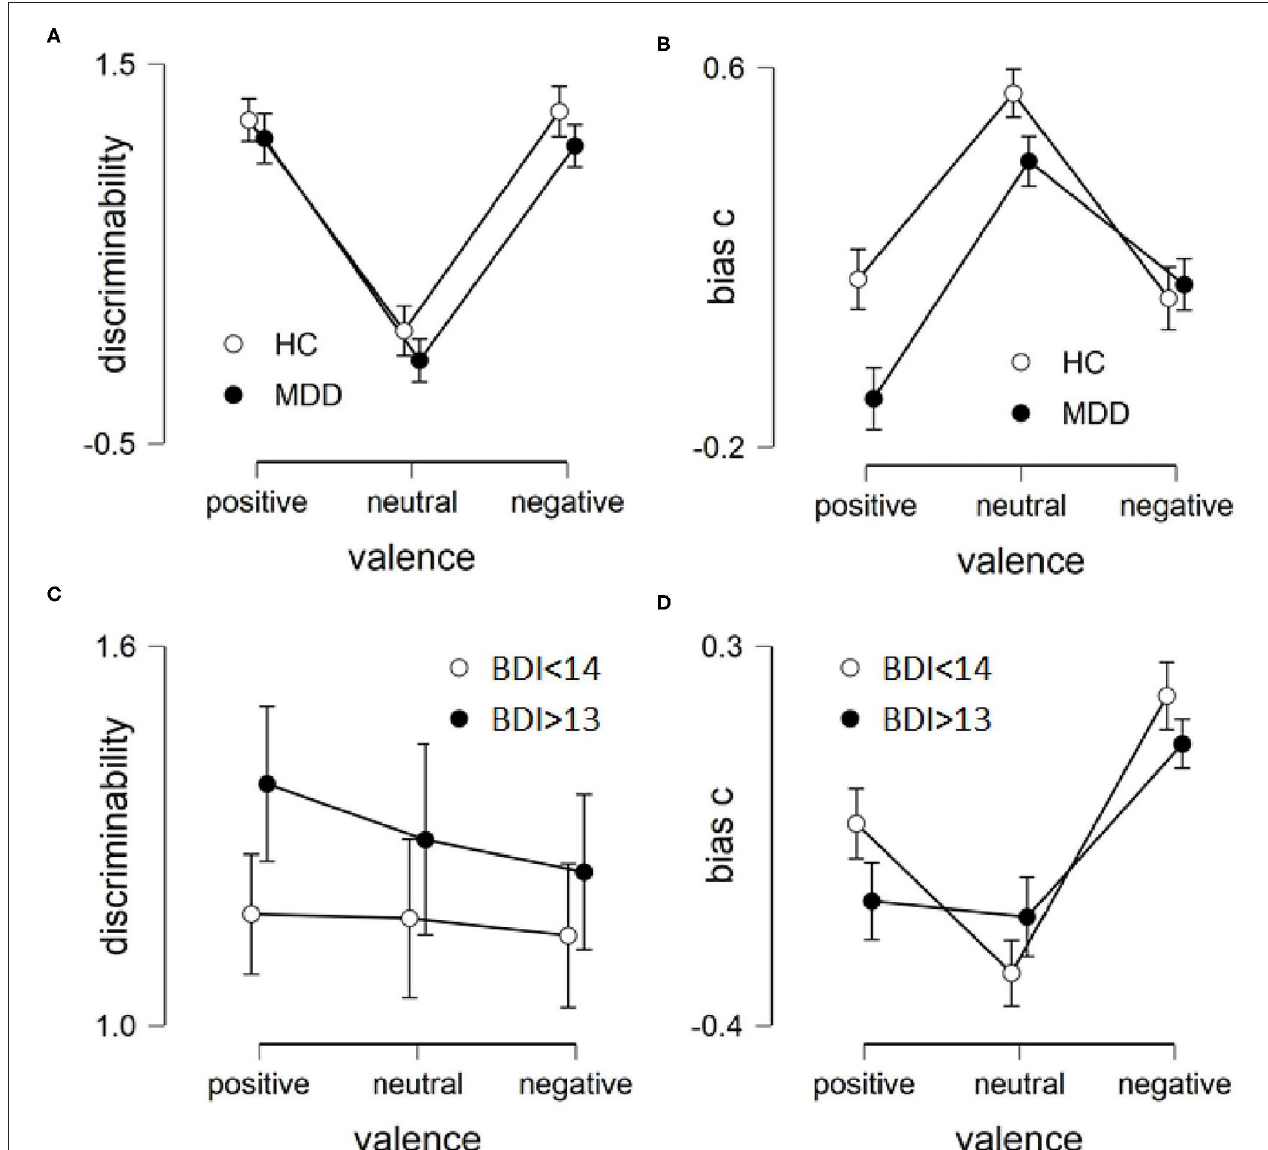
FIGURE 4 | Results of recognition task per group and emotion from both studies. Left row is accuracy in recognition, higher values indicate higher accuracy. (A) Study 1, (C) Study 2. Right row is bias, the tendency to say yes to having seen the images. Higher values indicate more reserved in saying yes. (B) Study 1, (D) Study 2. Error bars are